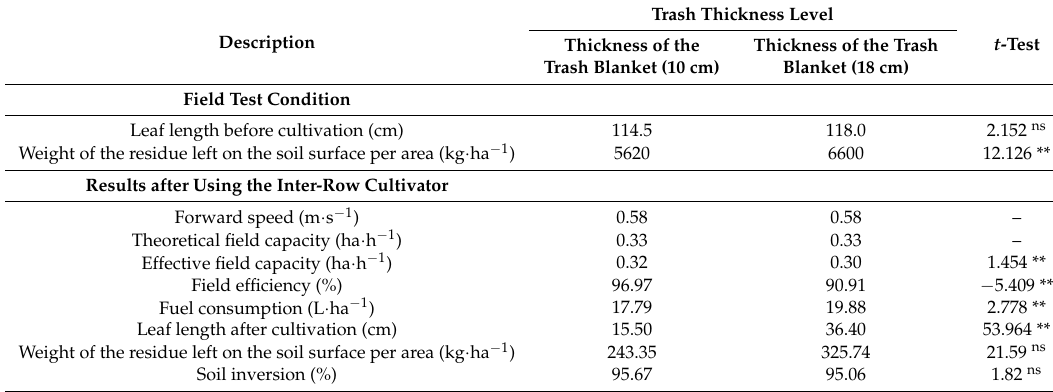
Table 5. The performance test and the practical field test of an inter-row cultivator attached to the 37.3-kW tractor at different thicknesses of the trash